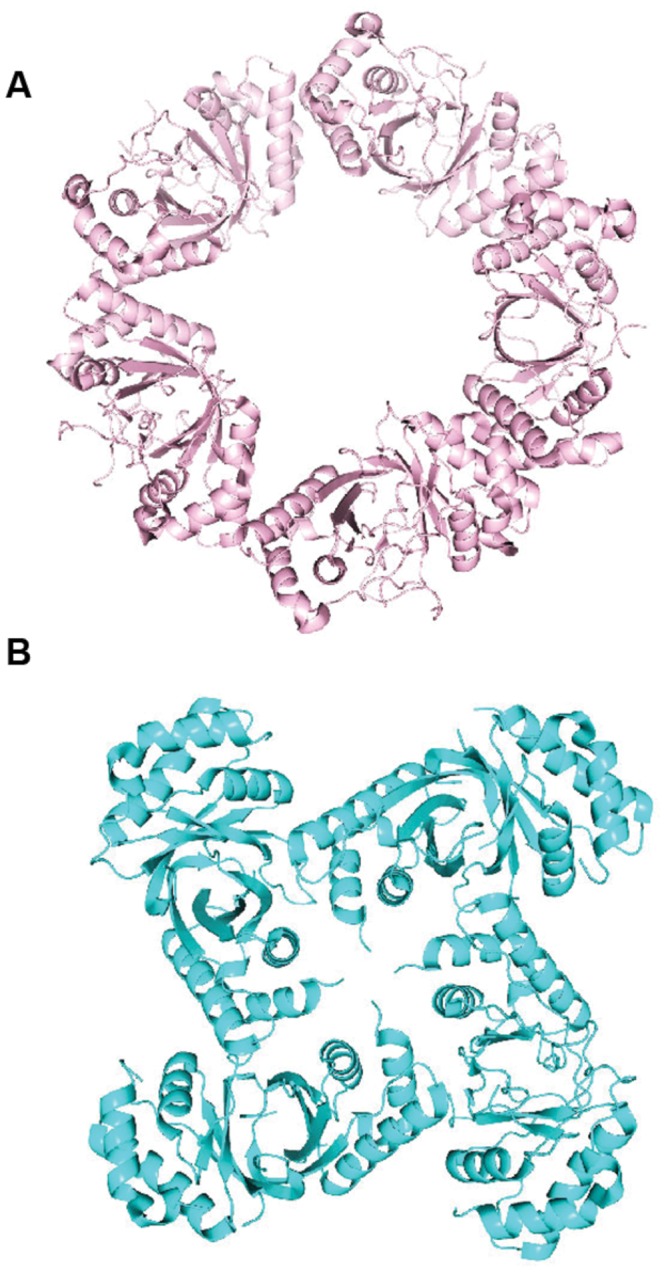
Higher-order crystal structures of the KSHV LANA DNA binding domain. (A) Ring form structure of the KSHV LANA DNA binding domain composed of 5 dimers (from PDB:4K2J.) (Domsic et al., 2013). (B) Non-ring form tetramer structure of KSHV LANA DNA binding domain (from PDB:5A76.) (Ponnusamy et al., 2015).